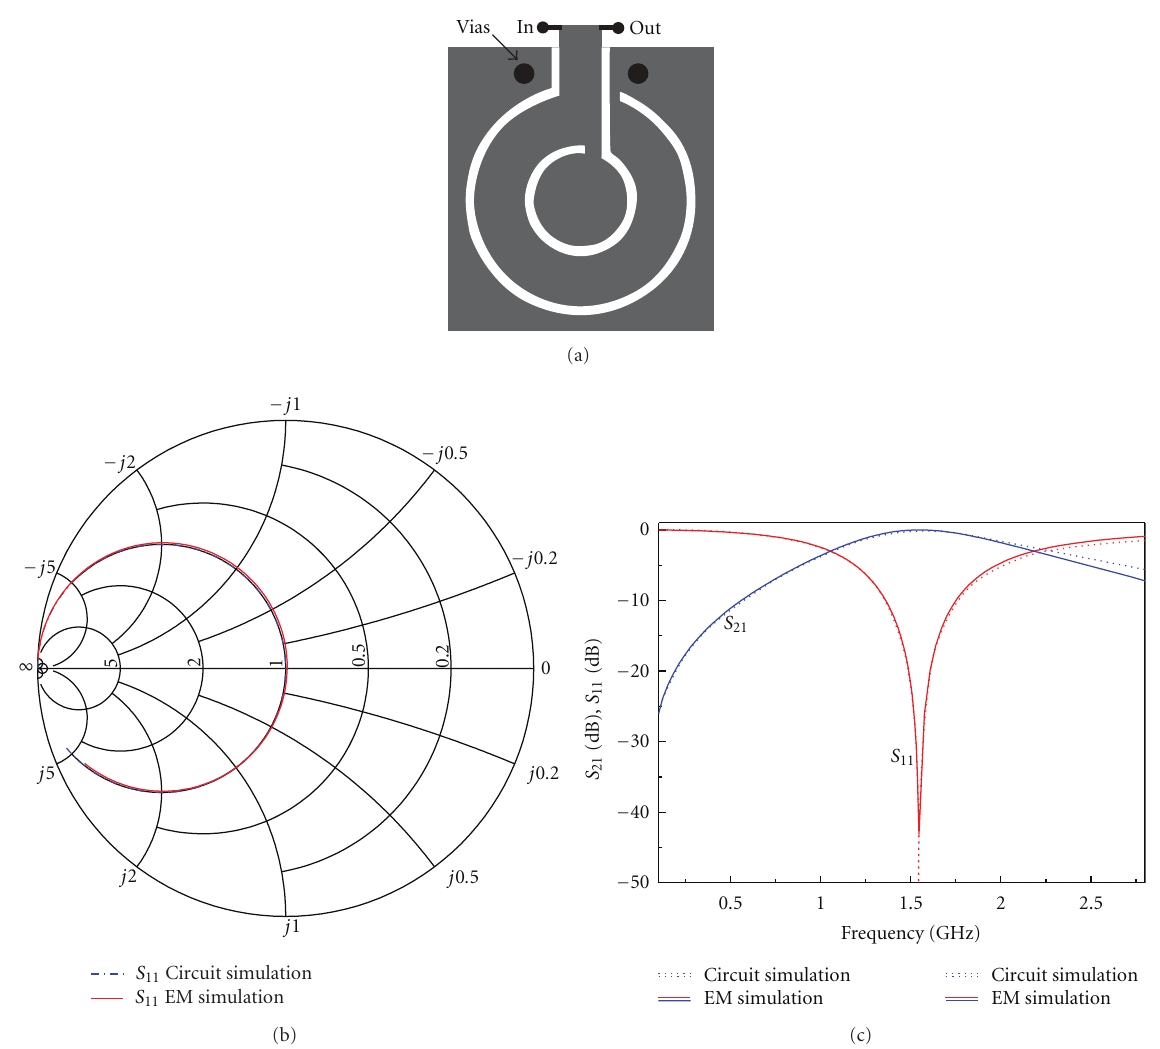
Figure 2: Topology (a), Smith Chart (b), and frequency response (magnitude) (c) of the electromagnetic and circuit simulation of a shunt OCSRR in microstrip technology with r ext = 2 . 7 mm, c = 0 . 2 mm, and d = 1 . 2mm. The considered substrate is the Rogers RO3010 with thickness h = 0 . 254 mm and dielectric constant ε r = 10.2. The element values of the shunt resonator in reference of Figure 1(b) are: . 02nH and C . 25 pF. L o = 2 c = 5